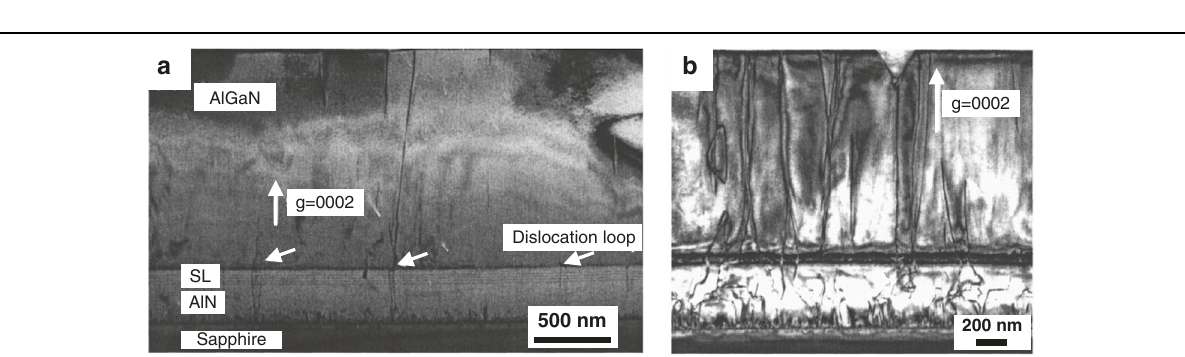
Fig. 4 AlGaN/AlN superlattice employed on the AlGaN growth. Cross-section TEM images [vector: g = (0002)] showing screw-component TDs in n-Al 0.55 Ga 0.45 N with ( a ) and without ( b ) superlattice insertion. Reprinted with permission from Sun et al. 108 . Copyright 2005 American Institute of